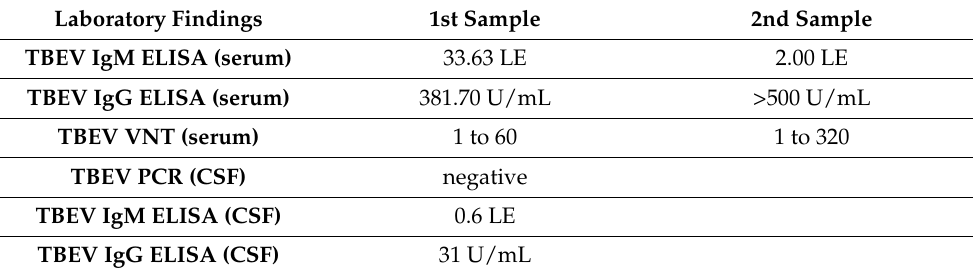
Table 1. Serological and cerebrospinal fluid (CSF) analysis results of a horse with tick-borne en- cephalitis. The first sample was taken 1 day and the paired second sample 32 days after the onset of neurological